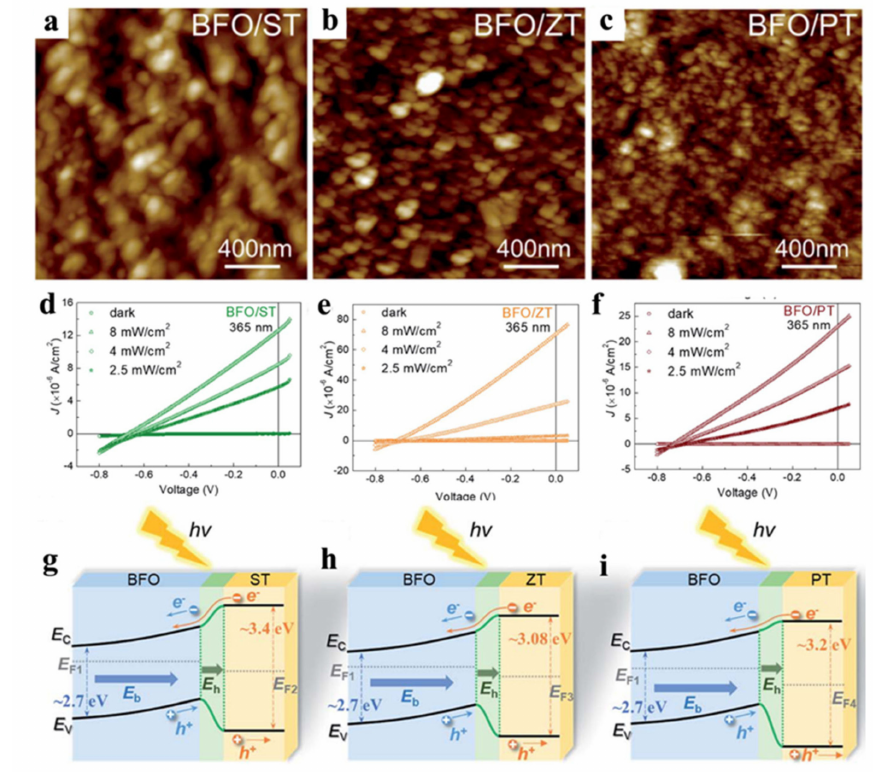
Figure 5. ( a – c ) AFM images of the BFO/XT film; ( d – f ) J–V curves under the illumination of 365 nm with different power density of BFO/XT film; ( g – i ) The band structure of the BFO/XT multilayer films under illumination. Adapted with permission from ref. [72], copyright: 2022, Royal Society of